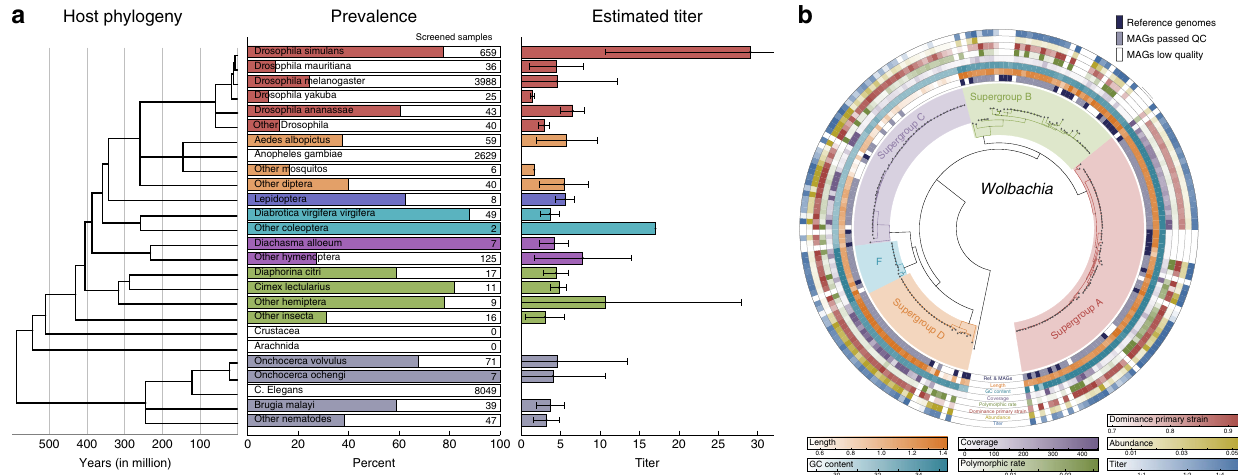
Fig. 1 Prevalence, titer, and genome characteristics of Wolbachia in the analyzed samples. a Host related prevalence and estimated titer of more than 30,000 screened samples in relation to the host species phylogeny based on Rota-Stabelli et al. 5 . Wolbachia prevalence is based on the fraction of host samples in which Wolbachia strains could be detected at 1X or higher coverage using PanPhlAn. Statistics are reported only for host species with at least 7 samples. Infectious titers of Wolbachia cells per host cell are estimated from the fraction of reads and normalized by Wolbachia and host genome size taken from http://www.genomesize.com/. Error bars indicate the standard deviation over all titers of samples from the same host species. b PhyloPhlAn tree based on 1166 assembled genomes; reported for each genome are genome length, nucleotide composition in terms of G + C content, depth of coverage, fraction of nucleotide polymorphisms and dominance of the primary strain, relative read abundance, and estimated titer (normalized abundance). The large branches of D. melanogaster and D. simulans are excluded and duplicated sequences are not shown for